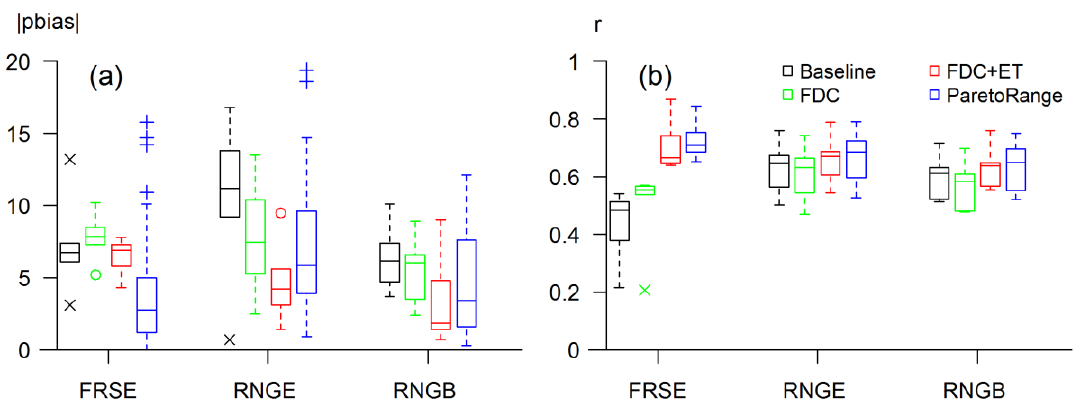
Figure 7. Comparison of 8-day simulated and remote sensing-based evapotranspiration annually (2002–2007) for evergreen forest (FRSE), savanna grassland (RNGE) and shrubland (RNGB) using boxplots: ( a ) percent of bias (pbias) and ( b ) correlation coefficient (r).